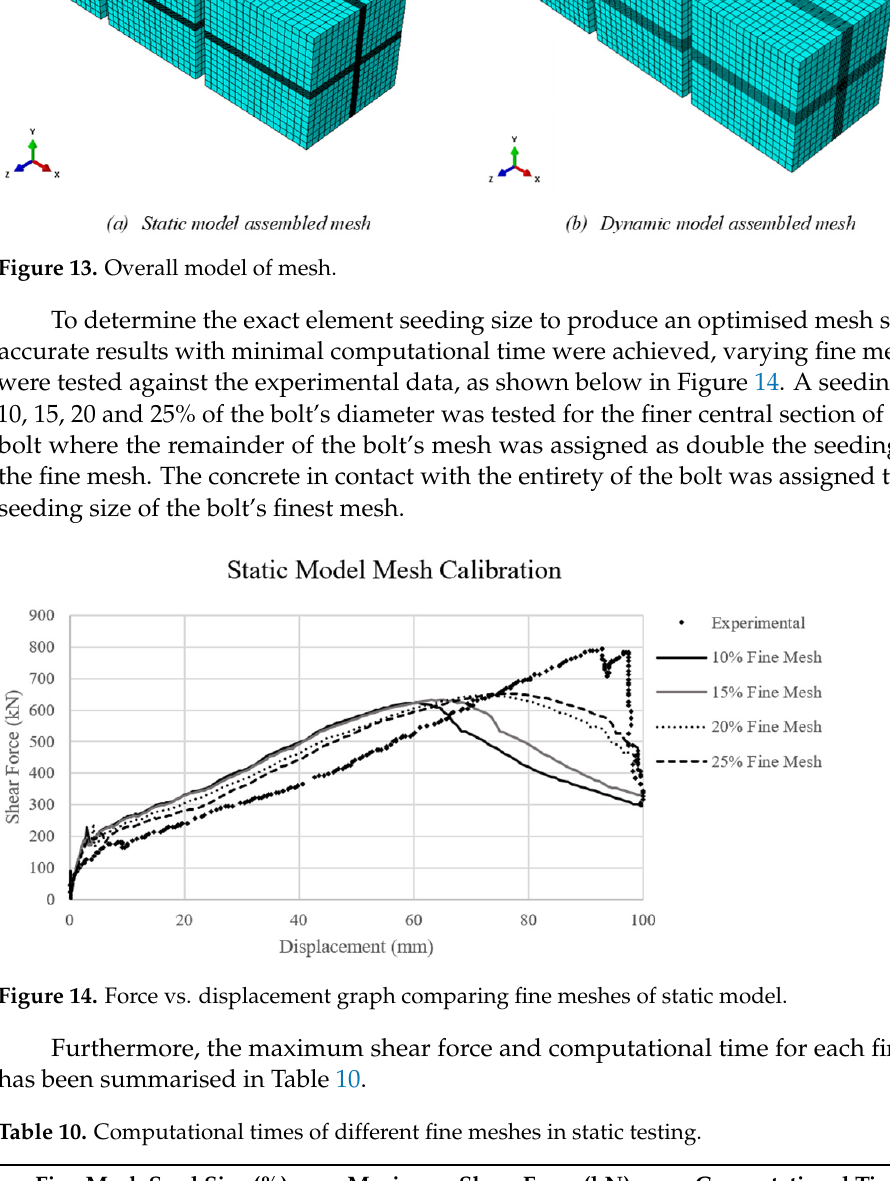
Table 10. Computational times of different fine meshes in static testing.